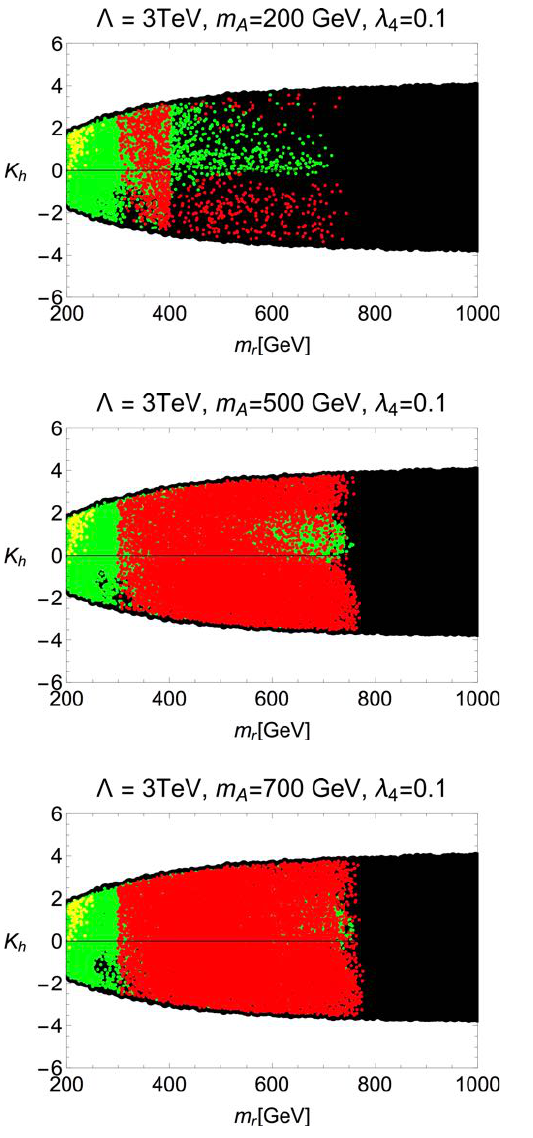
Figure 8 . Scatter plots of the amount of mixing between the Higgs and the radion, K h de(cid:12)ned in equation (3.5), as function of the radion mass for the type-I 2HDM. The black region is theoretically allowed and the points colored yellow, green and red are forbidden by heavy scalar searches in the WW , ZZ and hh channels respectively. The benchmark point (cid:3) = 3(5)TeV was used on the left (right). Due to the custodial symmetry, the charged scalar mass is identical to the pseudoscalar mass, whose value is given above each (cid:12)gure. The heavy neutral Higgs mass, m H , is varied from 200 to 1000